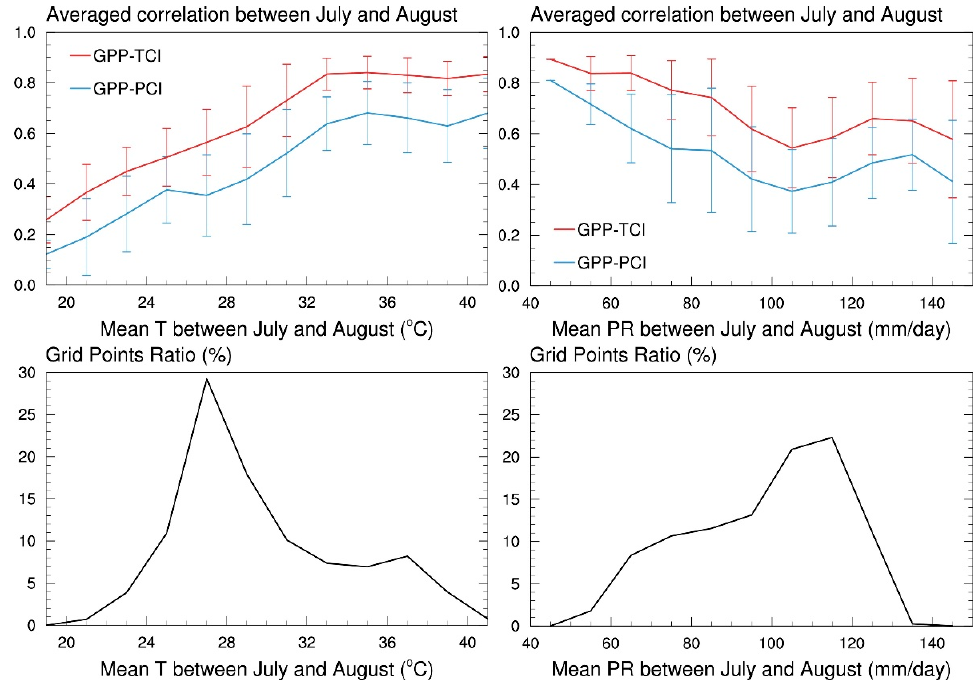
Figure 5. Correlations of GPP-TCI (red) and GPP-PCI binned by long-term mean summer ( left ) temperature and ( right ) precipitation using the 0.05 ◦ data in the 12 states of major maize and soybean production. Top rows indicate the average of correlation between July and August, and bottom rows indicate a ratio of the number of grid points in each bin. In the top rows, standard deviation of correlations in each bin is indicated as vertical ranges.